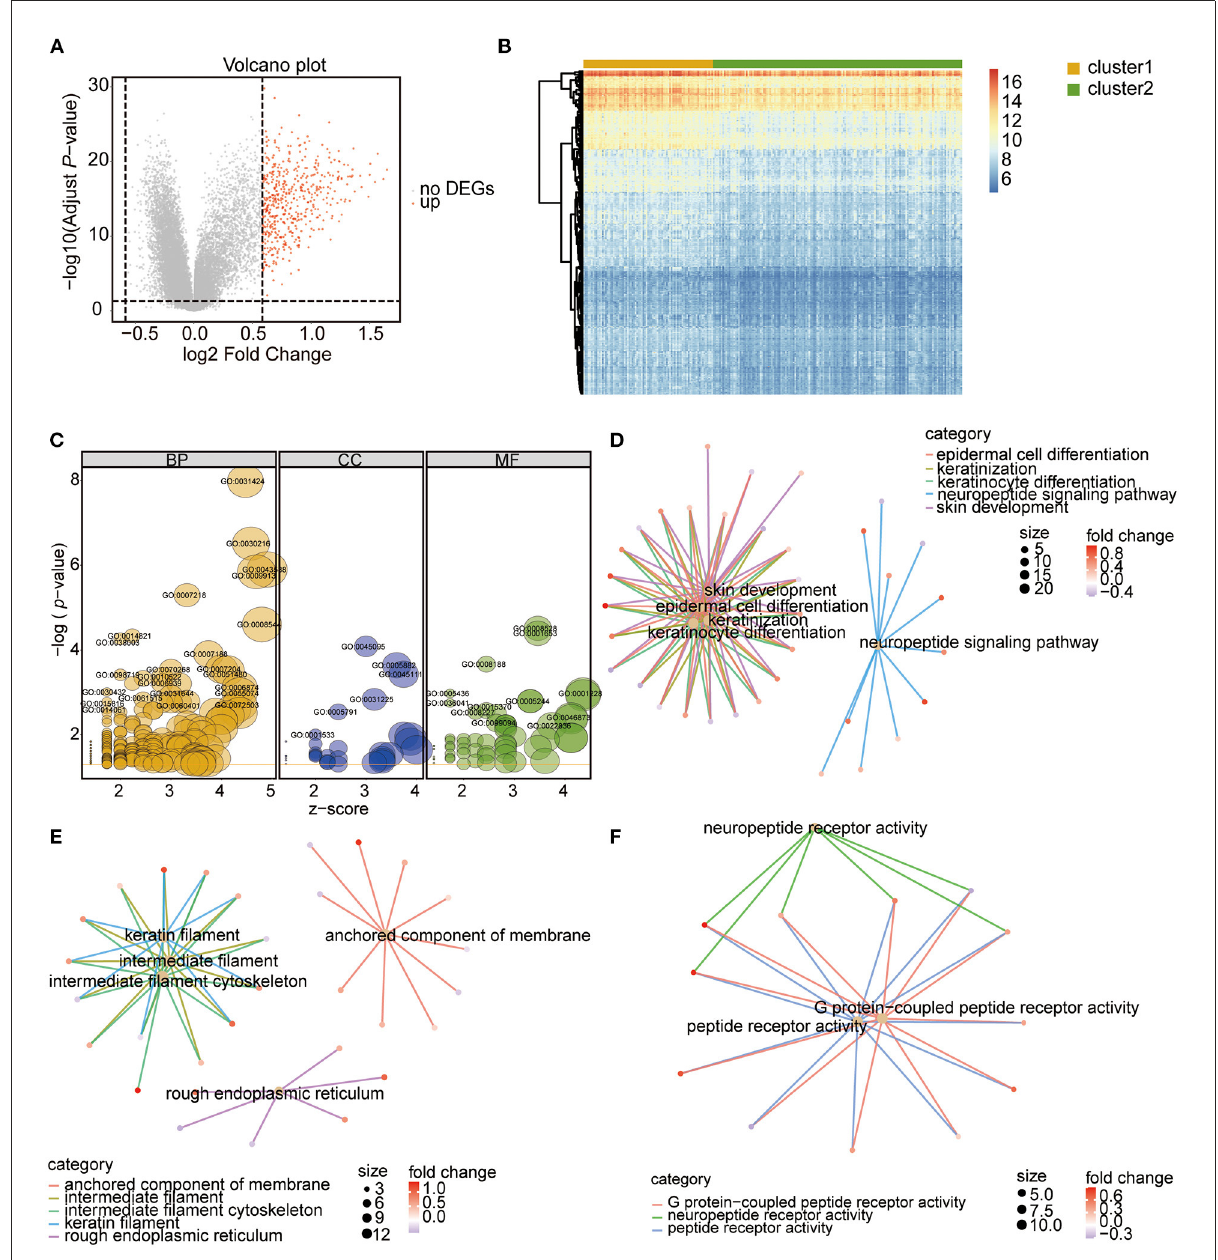
FIGURE5 Identification and function analysis of DEGs between the two m6A RNA modification patterns. (A) Volcano Plot showing the DEGs in cluster 1 vs. cluster 2 subgroups. The red dots represent up-regulated genes, the gray dots represent genes with no significant difference. DEGs were identified with the threshold of adjust P -value < 0.05 and Fold change > 1.5. (B) Heatmap showing the DEGs in cluster 1 vs. cluster 2 subgroups. (C) GO functional enrichment analysis of the DEGs. The node size represents the number of genes contained in the current GO Term.